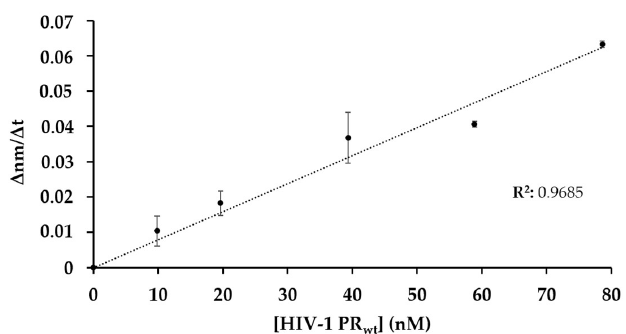
Figure 4. Dependence of initial change in the bio-layer thickness on enzyme concentration. The proteolysis was performed at increasing concentration of HIV-1 PR wt . The initial ∆ nm/ ∆ t values were determined based on the slopes (2–10 s after initiation of the reaction). Error bars represent SD (n =